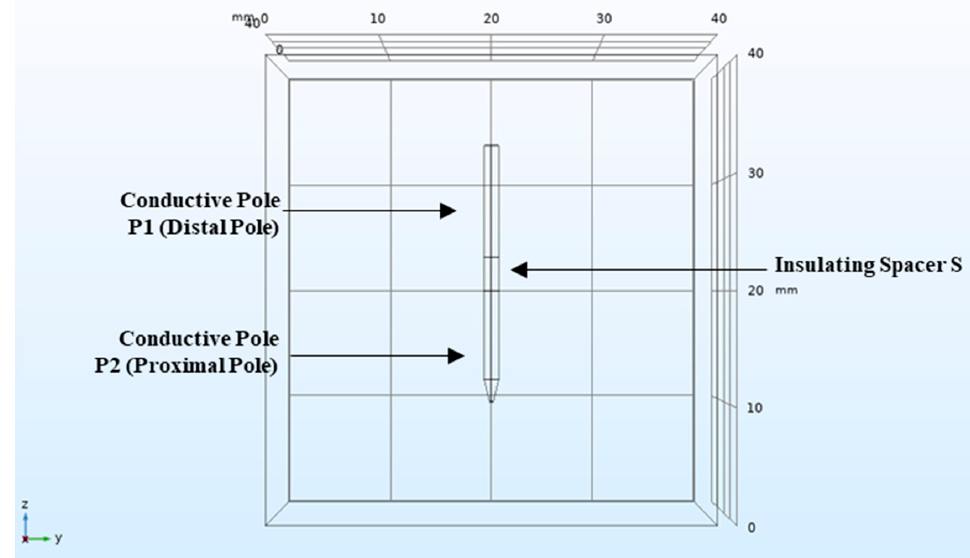
Figure 8. Simplified electrode geometry implemented in Comsol Multiphysics ® and used for theoretical study. The geometry is composed of two conductive poles (austenitic stainless-steel) and one insulated spacer (polyimide). The electrode is inserted in a cube representing the organ of